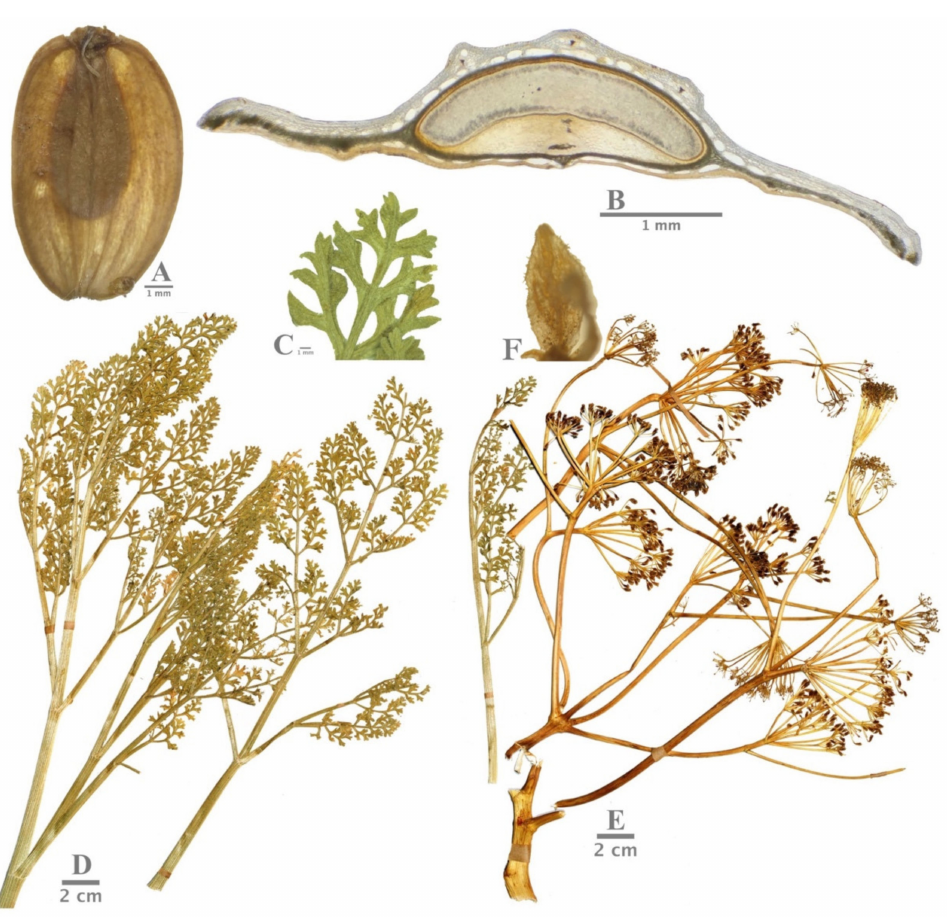
Figure 2. ( A ) General view of Ferula turcica fruit. ( B ) Cross-section of mericarp of F. turcica . ( C , D ) Basal leaf of F. turcica . ( E ) General view of F. turcica umbella. ( F ) Petals with setulose-puberulent